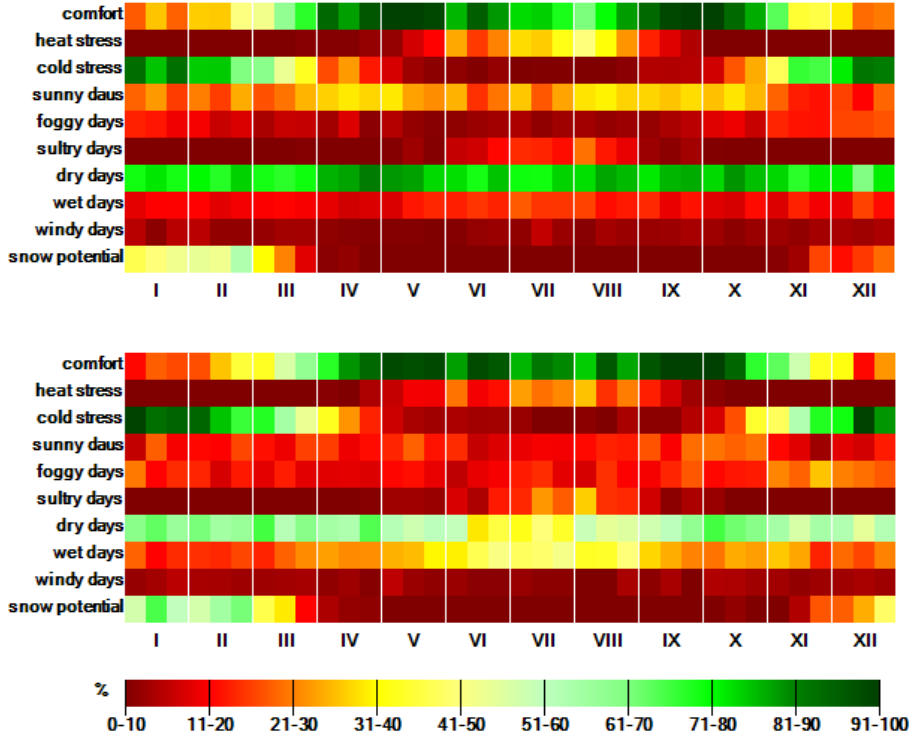
Figure 15. CTIS in Słoszów for anticyclonic ( top) and cyclonic (bottom) types of circulation in 1971 – 2010.